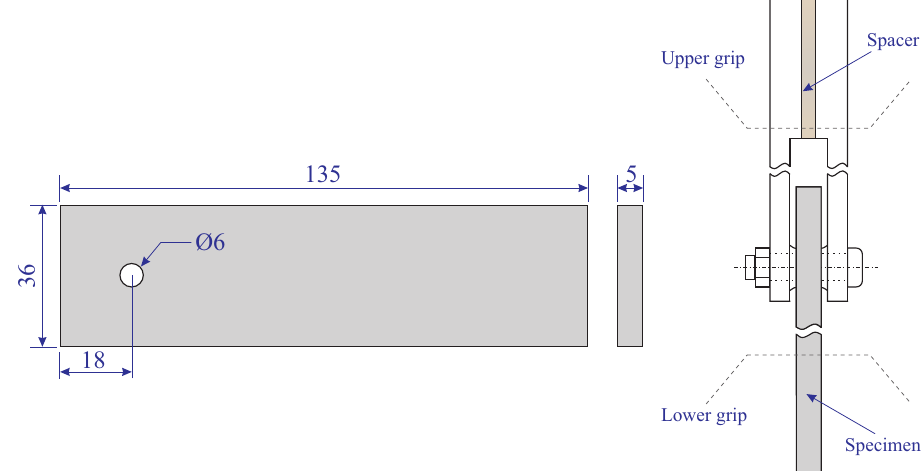
Figure 1. The schematics of double-shear samples and the fixture loading plate (dimensions in